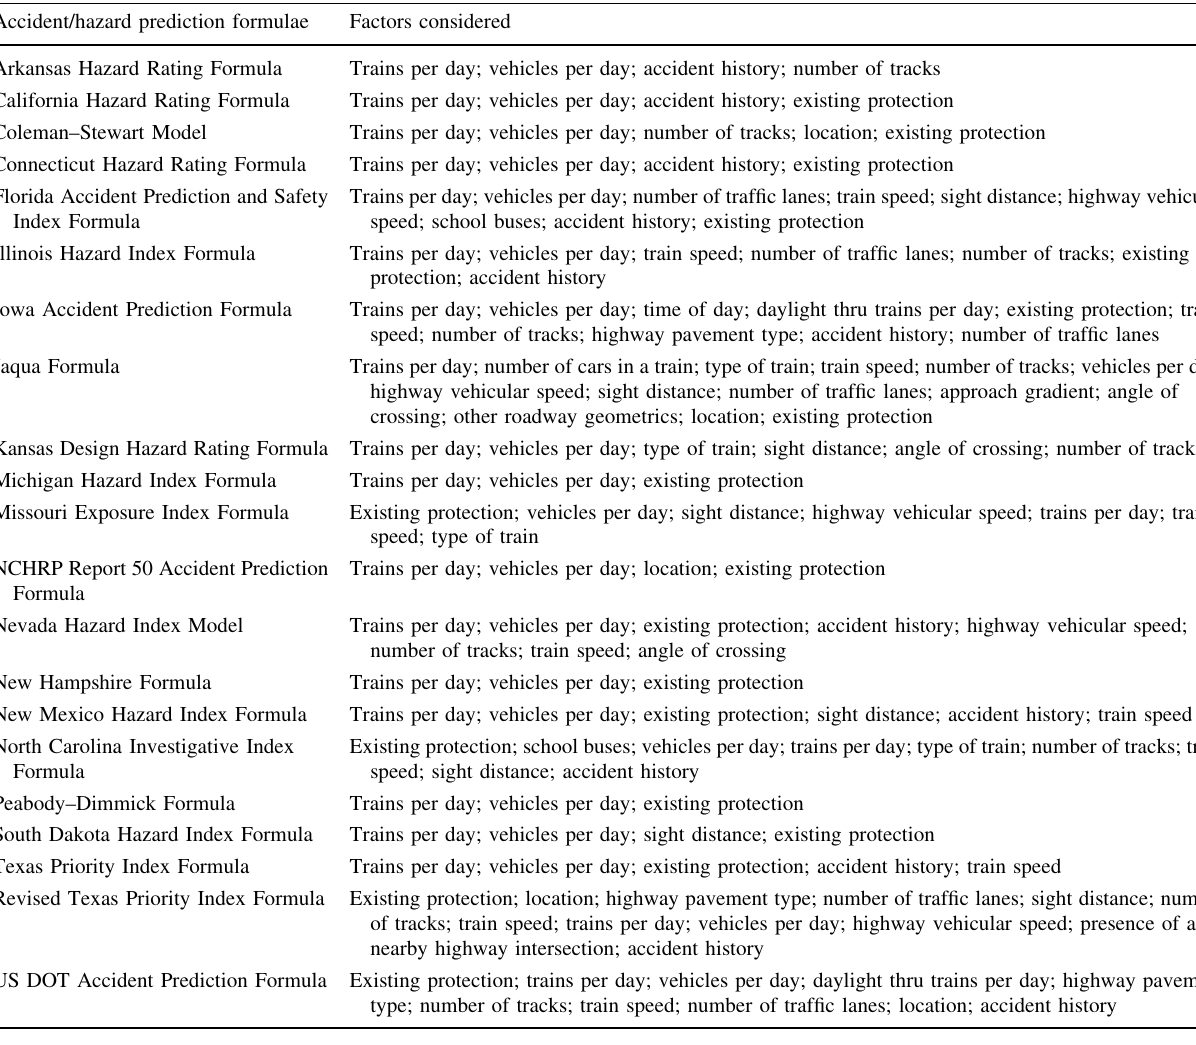
Table 7 Factors considered by the identified accident and hazard prediction formulae Accident/hazard prediction